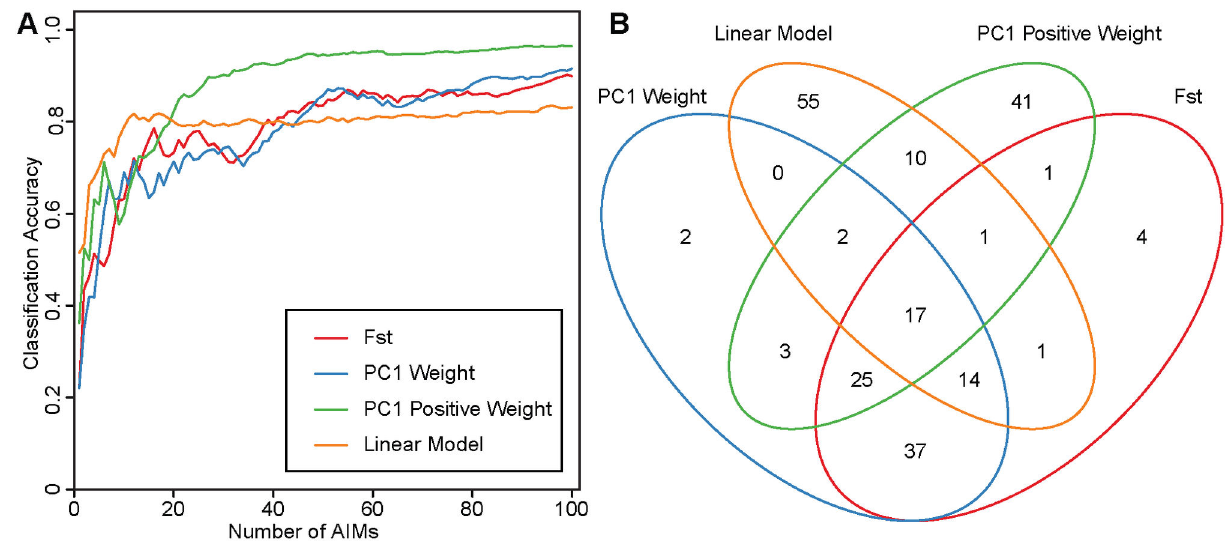
Figure 4. Comparison of measures of informativeness for identifying AIMs. (A) Each measure used to rank AIMs is shown in the legend. For each measure, the proportion of V. vinifera ancestry across the 127 hybrids was estimated using 1-100 SNPs ranked according to that measure and the result was compared to the proportion of V. vinifera ancestry estimated from the full set of 2959 SNPs. The classification accuracy (Y axis) is the squared Pearson correlation coefficient (R 2 ) between the estimate derived from the reduced set of AIMs and the estimate from the full set of SNPs. (B) A Venn diagram showing the overlap of the top 100 AIMs identified using each of the